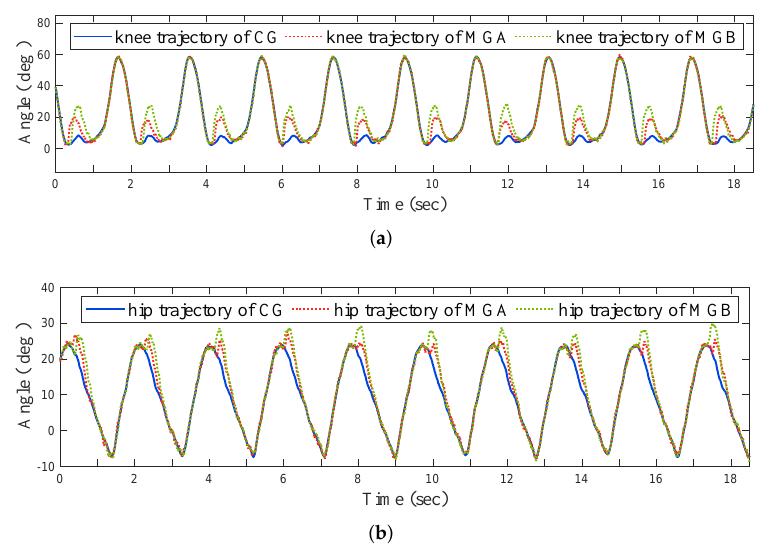
Figure 10. Joint angles of the AIDER walking at about 0.5 m/s. ( a ) Knee joint trajectories. ( b ) Hip joint